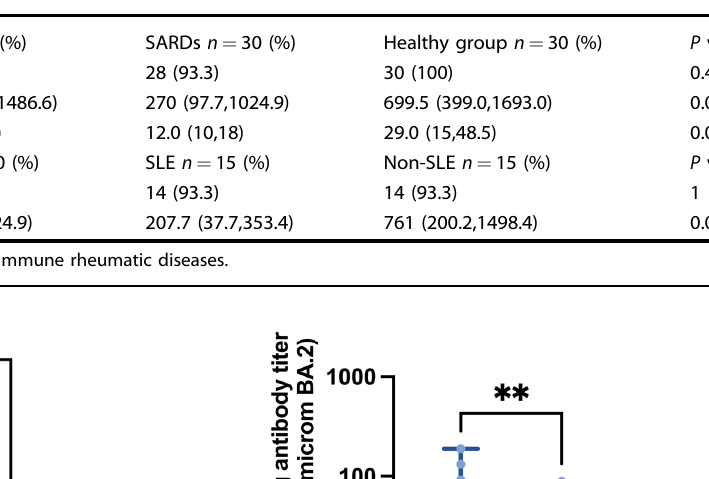
Table 3. Immunogenicity of CoronaVac followed by ChAdOx1 nCoV-19 (Oxford-AstraZeneca) in patients with systemic autoimmune rheumatic diseases (SARDs) and the healthy group.